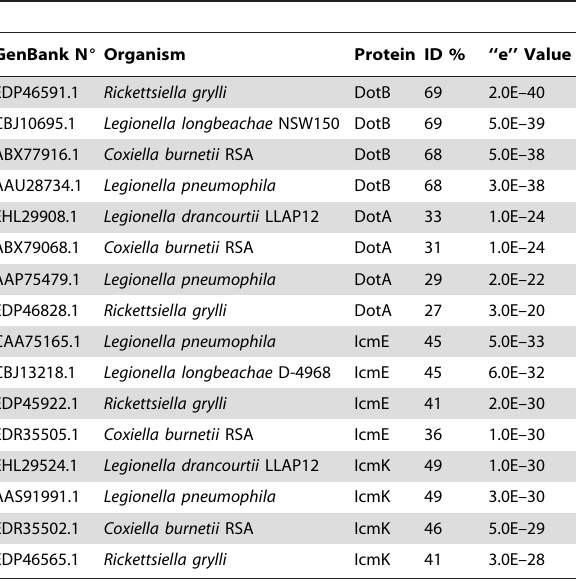
Table 4. Hydrophobic domains of the P. salmonis DotA protein obtained using the SOSUI